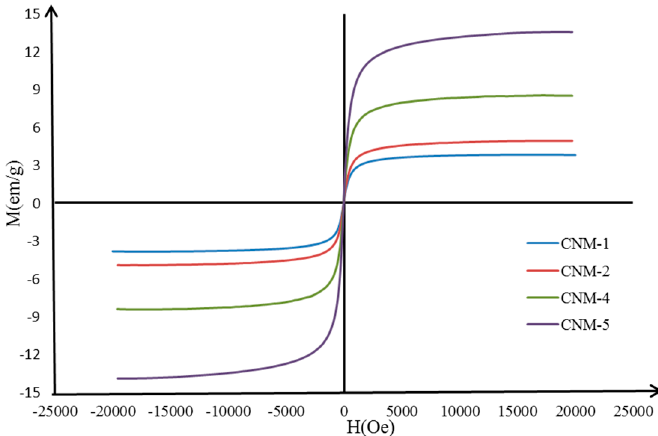
ff erent magnetic